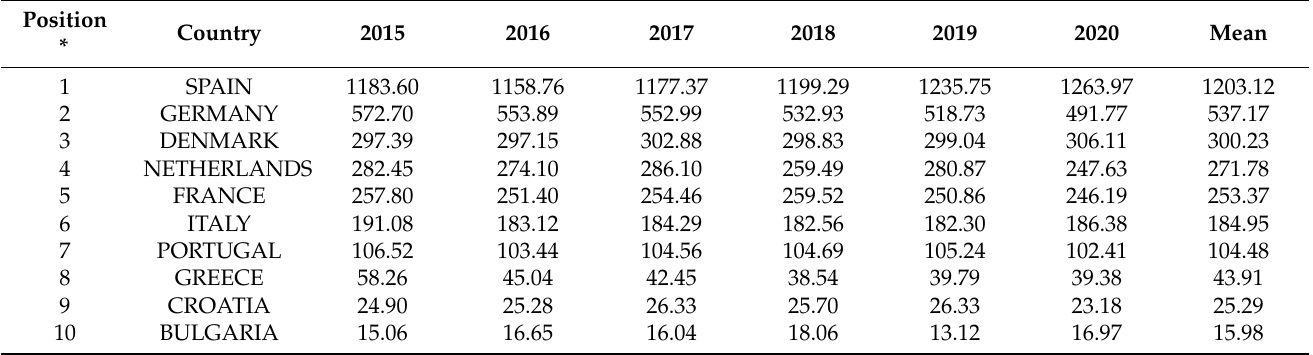
Table 8. Results of CH 4 emissions from manure management using GLEAM-i software (FAO, Rome, Italy) (Gg CO 2 -eq/year).